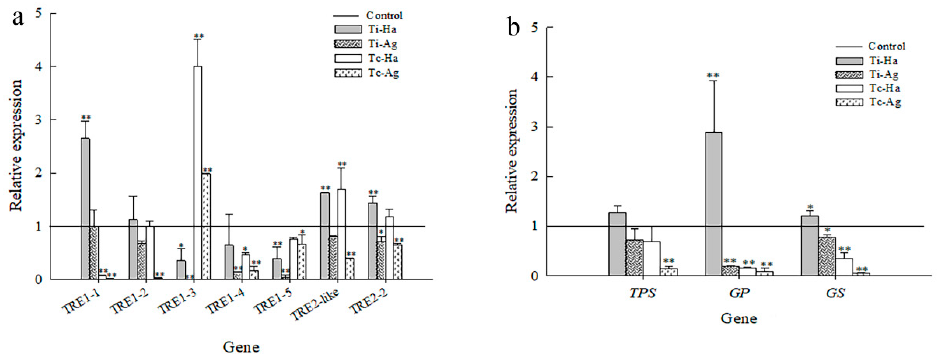
Figure 6. ( a ) Relative expression levels of trehalase genes in ladybirds. ( b ) Relative expression levels of genes related to sugar metabolism in ladybirds. Note: Tre1-5: soluble trehalase gene; Tre2-like and Tre2-2: membrane-bound trehalase gene; TPS: trehalose-6-phosphate synthase gene; GP: glycogen phosphorylase, glycogen phosphorylase gene; GS: glycogen synthase gene. * and ** on the column represent significant and extremely significant differences from the control group at 0.05 and 0.01 (one-way ANOVA), respectively.